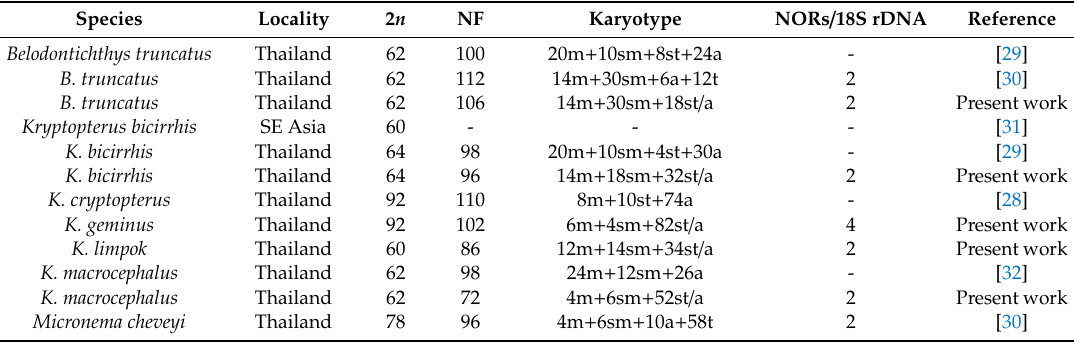
Table 1. Review of cytogenetic data in the family Siluridae. The species now analyzed are highlighted.